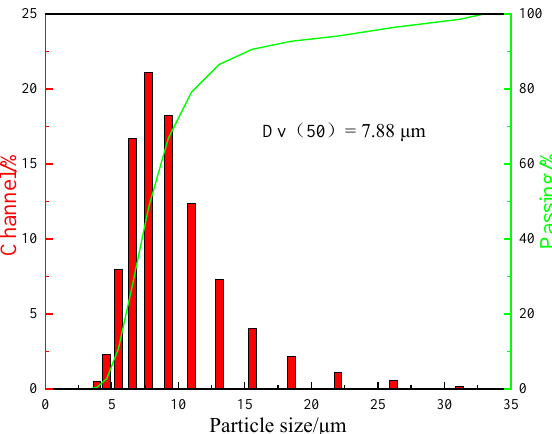
Figure 3. Particle size distribution diagram of SG powder.